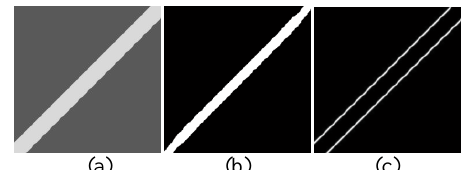
Figure 6. Illustration of ridge-based and edge-based line detection on a synthetic image